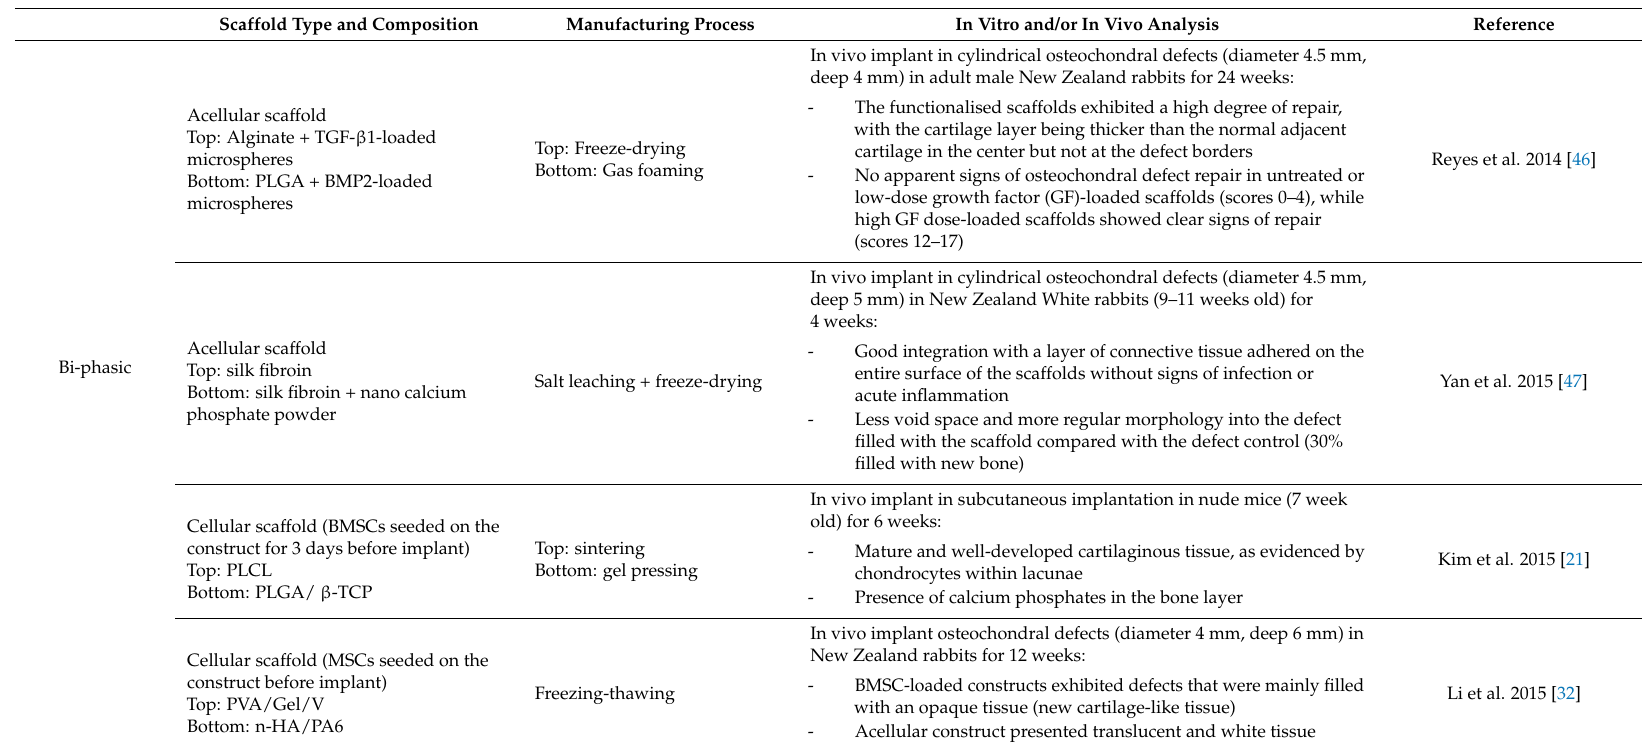
Table 2. Summary table on the most recent in vivo implant of bi-phasic and multi-phasic osteochondral scaffolds. Scaffold Type and Composition